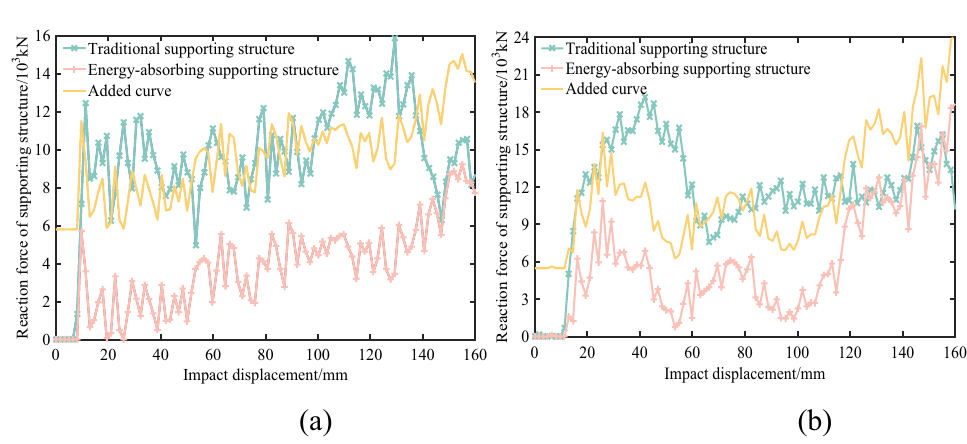
Figure 8. Reaction force of supporting structure: ( a ) under top impact condition. ( b ) Under side impact